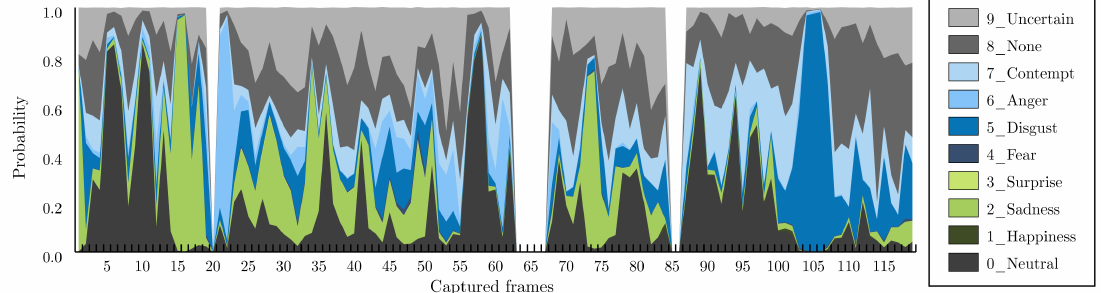
Figure 9. Example of detected emotion